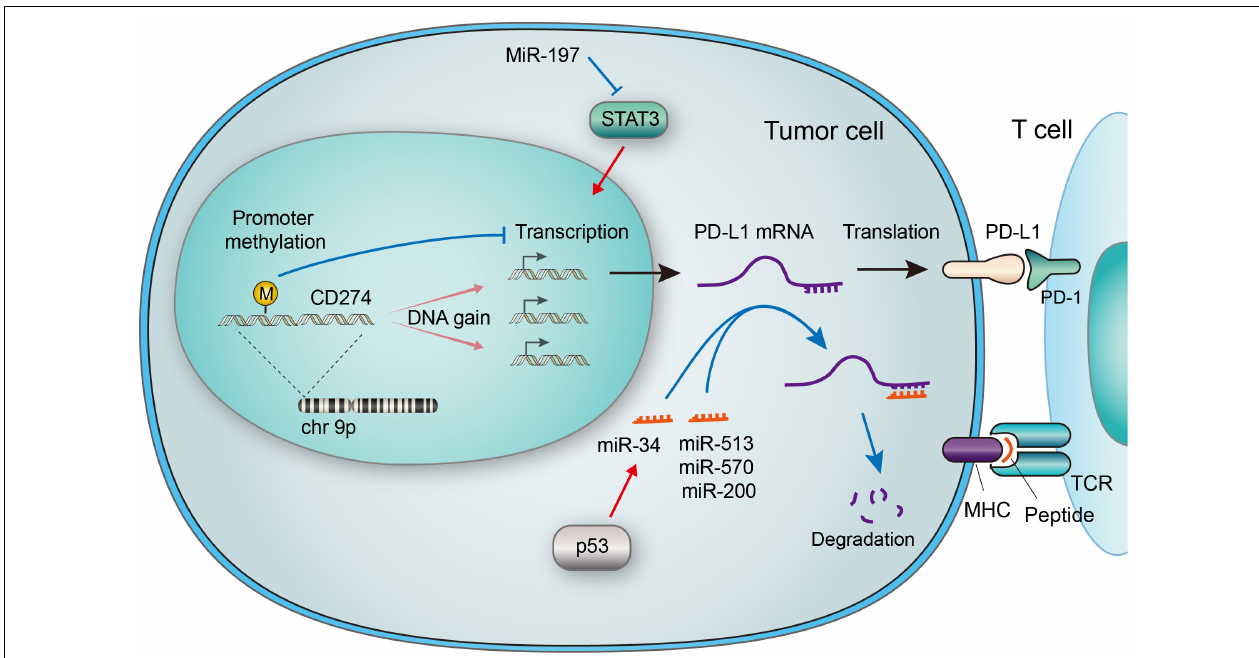
FIGURE 1 | Genetic and epigenetic regulations of PD-L1 in tumor cells. The CD274 gene encoding PD-L1 is located on chromosome 9p, which is amplified in a subset of cancers. Increased gene copy number leads to upregulation of mRNA expression, while methylation of the gene promoter suppresses its transcription. Micro RNAs (miRNAs) may regulate PD-L1 expression by suppressing Stat3, which transactivates PD-L1. MiRNAs may also bind to the 3 (cid:48) UTR of PD-L1 mRNA, leading to its degradation. The p53 tumor suppressor has been reported to downregulate PD-L1 through miR-34, a miRNA that binds to the 3 (cid:48) UTR of PD-L1 mRNA. The PD-L1/PD-1 interaction and MHC-antigen/TCR interaction collaboratively define an inhibitory output of the immune